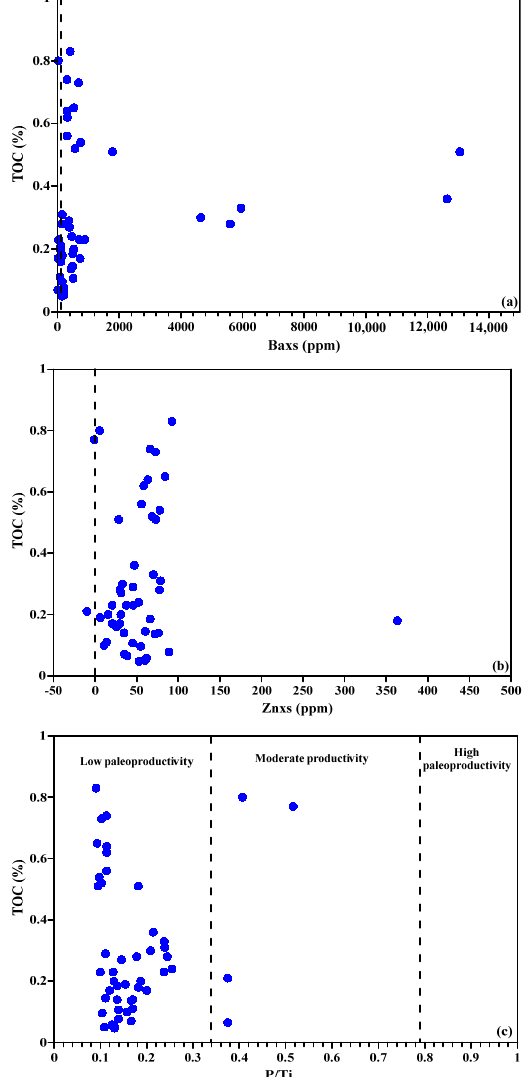
Figure 6. Paleoproductivity discrimination of the mudstones in the Meitan Formation. TOC = Total organic carbon. ( a ) relationship between Baxs and TOC; ( b ) relationship between Znxs and TOC; ( c ) relationship between Pi/Ti and TOC.